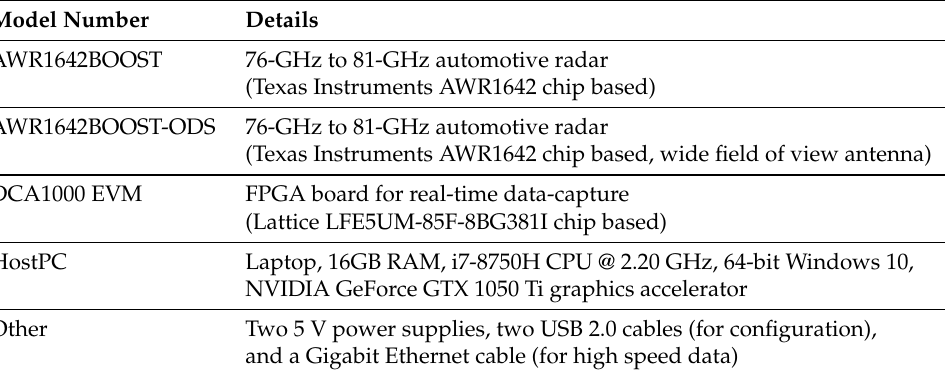
Table 1. List of equipment.